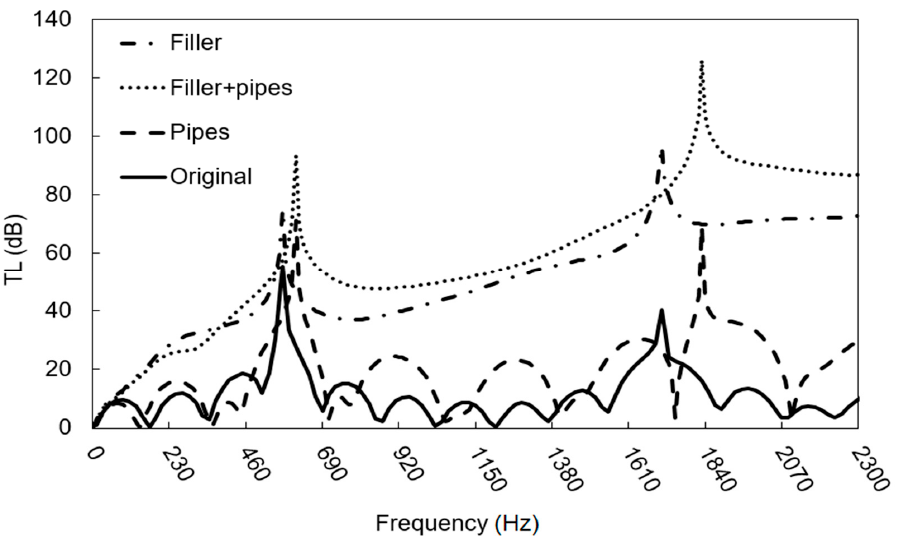
Figure 17. Influence of the insertion of a perforated pipes and filler on the model-scale scrubber